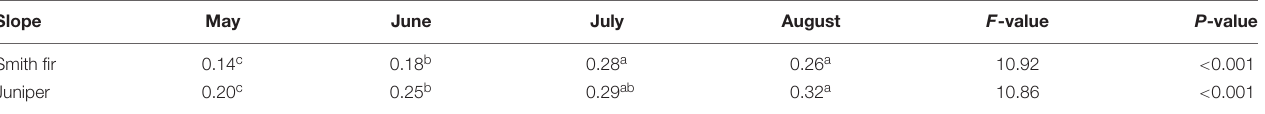
TABLE 2 | Differences in slopes of single linear regressions of hourly sap flow density vs. vapor pressure deficit ( D ) across Smith fir and juniper trees over the growing-season months were tested using analysis of covariance (ANCOVA). Slope